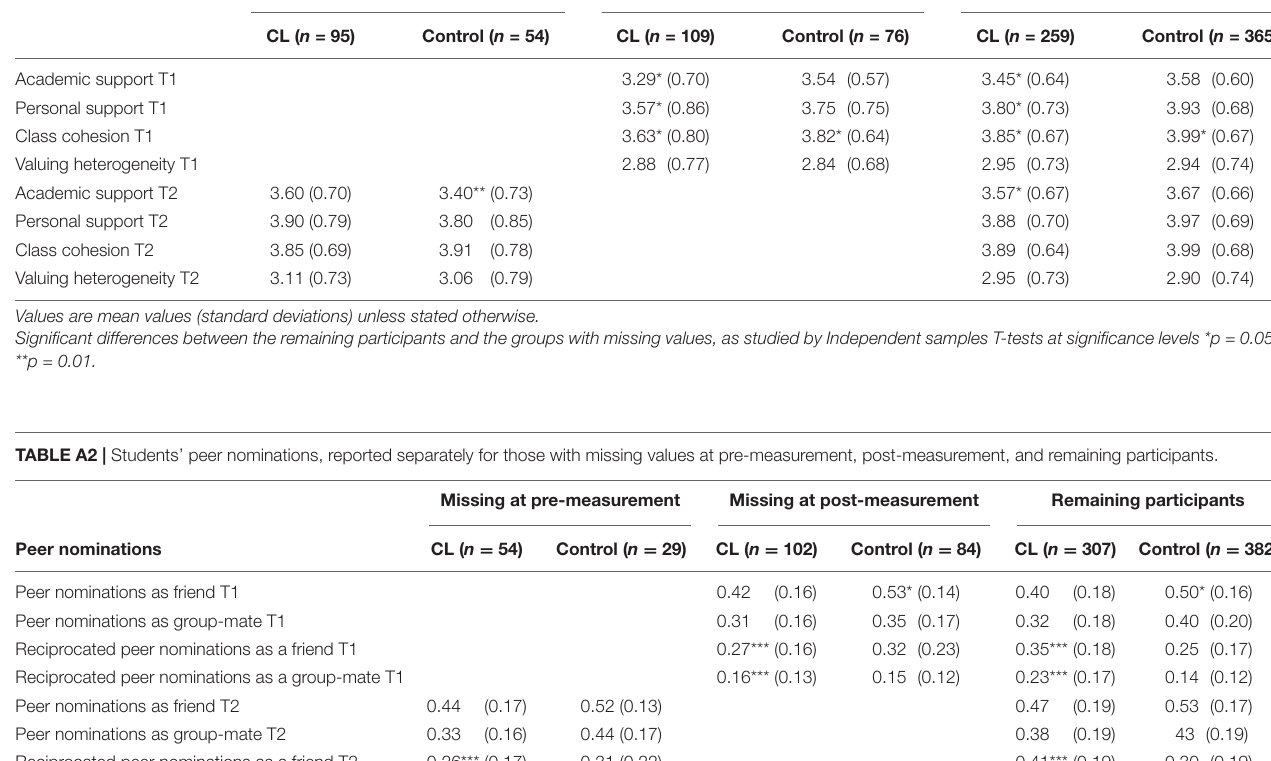
TABLE A1 | Students ratings of perceived classroom relationships in questionnaire Classroom Life Instrument, reported separately for those with missing values at pre-measurement, post-measurement and remaining participants. Missing at pre-measurement Missing at post-measurement